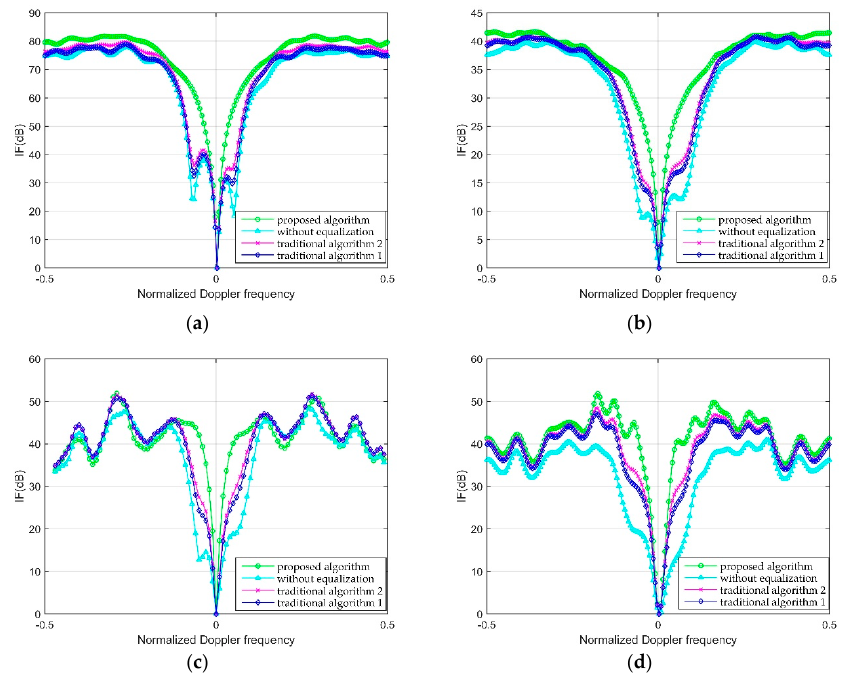
Figure 4. IF comparison with different algorithms: ( a ) Full STAP; ( b ) 3DT-STAP; ( c ) JDL-STAP; ( d ) AEP-STAP. ( d )